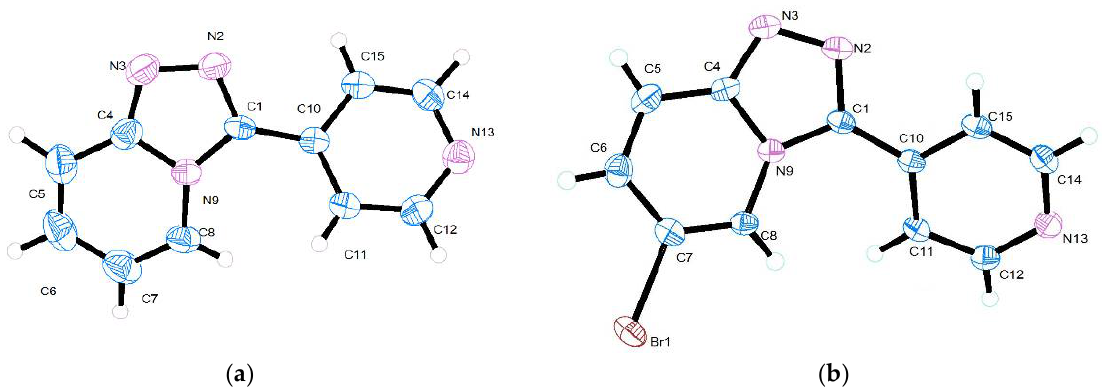
Figure 1. Molecular structures with atom numbering of ( a ) 3-(pyridin-4-yl)-[1,2,4]triazolo[4,3- a ]pyridine 1 ; ( b ) 6-bromo-3- (pyridin-4-yl)-[1,2,4]triazolo-[4,3- a ]pyridine 2